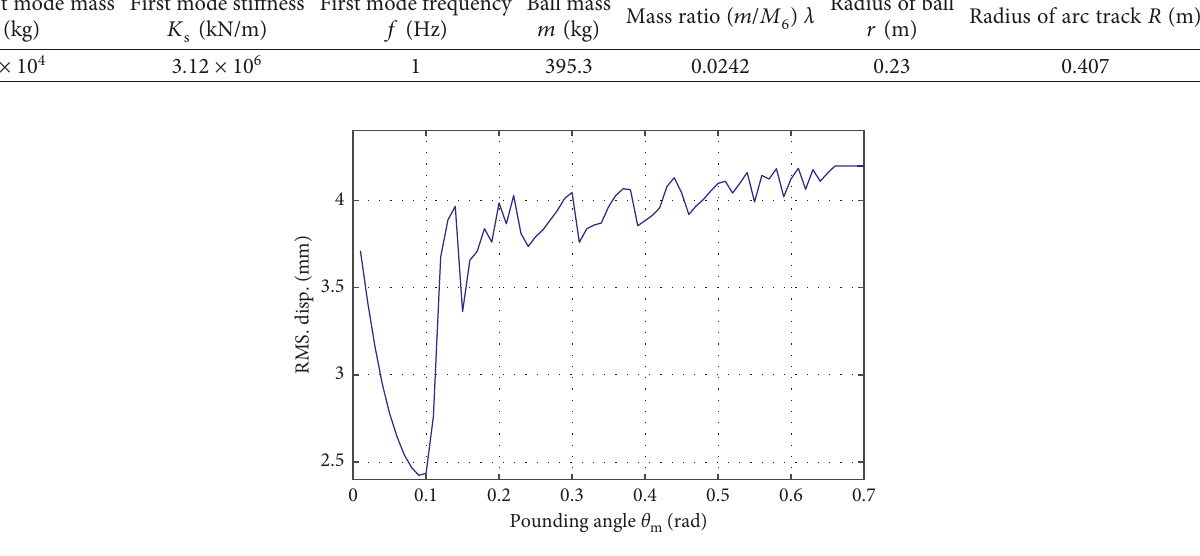
Figure 11: Relation of the structural displacement RMS and pounding angle.